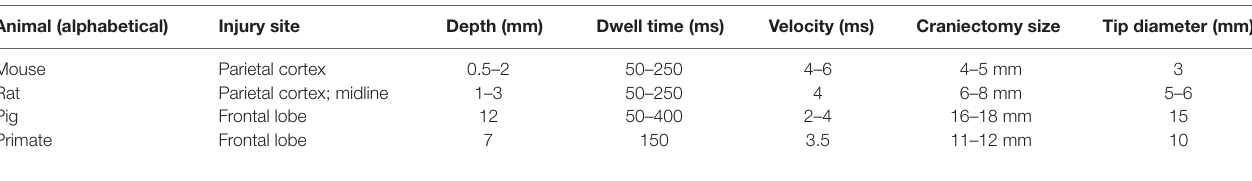
TABLe 2 | Summary of species CCi has been used and examples of injury parameters. Animal